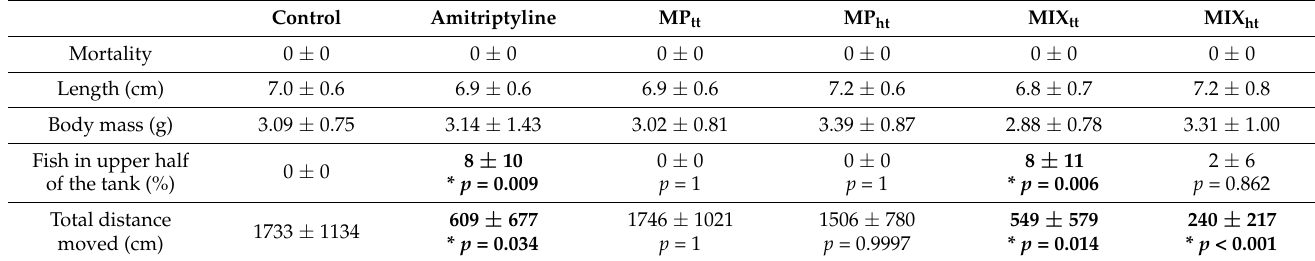
Table 4. Summary of the results of the second experiment (MP tt : 10 4 particles/L PS MP; MP ht